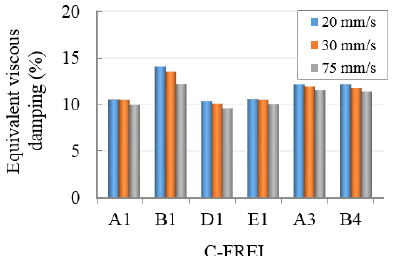
Figure 12. Equivalent viscous damping of C-FREIs under different lateral cyclic rates (20, 30, and 75 mm/s) at 50% shear strain.